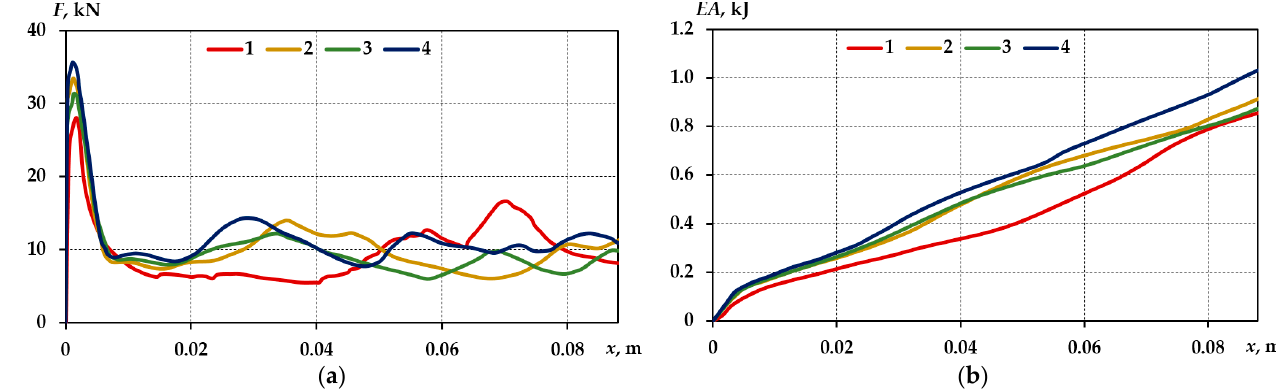
Figure 4. Buckling force ( a ) and absorbed energy ( b ) diagrams of the T1 section element, when the material is approximated with different descriptions; (1—in situ experiment; 2—by approximation with tangent modulus; 3—by approximation with exponential hardening function without accounting for the values of true stresses at break; 4—by approximation with exponential hardening function by accounting for the value of true stresses at break).